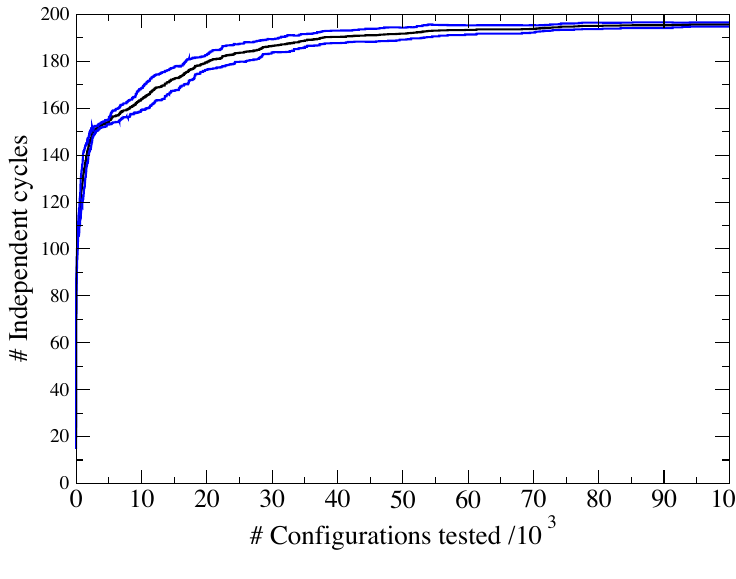
Figure 3. The number of independent loops identified in the metabolic network of E. Coli iAF1260 as a function of the number of random configurations tested. Results are obtained by jackknifing over 10 configurations. The black line represents the average number of loops, while the blue lines represent the extremes of the error bars at each